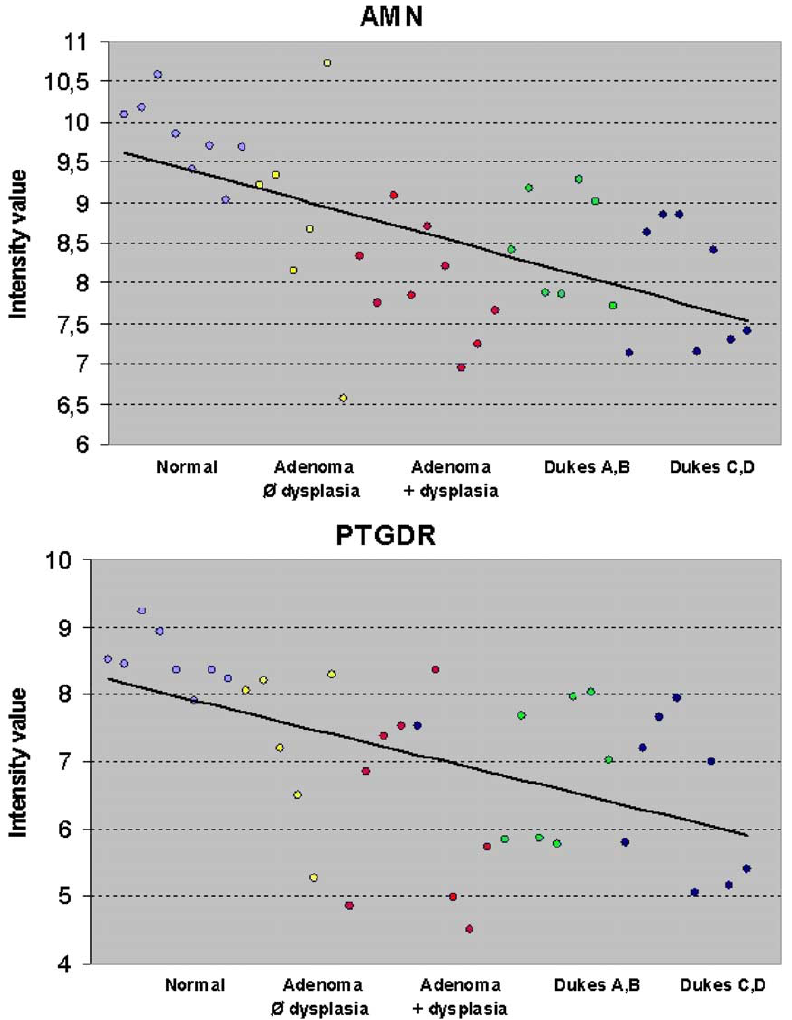
Fig. 1. Amnionless homolog and prostaglandin D2 receptor mRNA expression sequentially decreases during the normal–adenoma–dysplasia– carcinoma transition. ations, and the results were validated with RT-PCR and on tissue